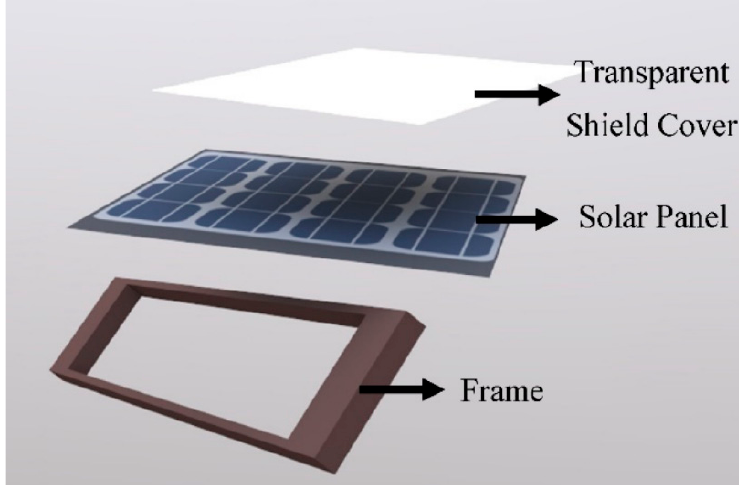
Figure 9. Schematic diagram of the pavement solar box [54].